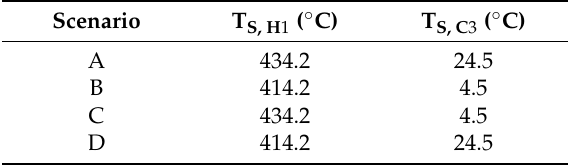
Table 5. Uncertain parameters for the considered inlet